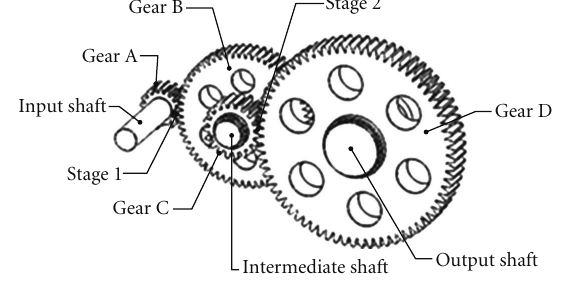
Figure 2: Two-stage gear train. Table 1: Gear design